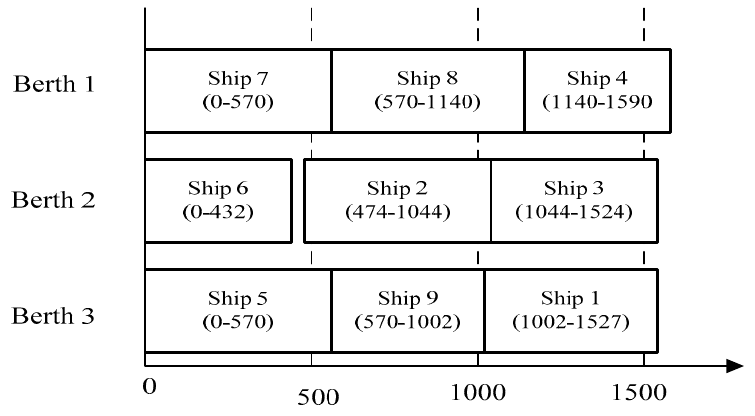
Figure 3. The berthing planning for 9 calling ships.